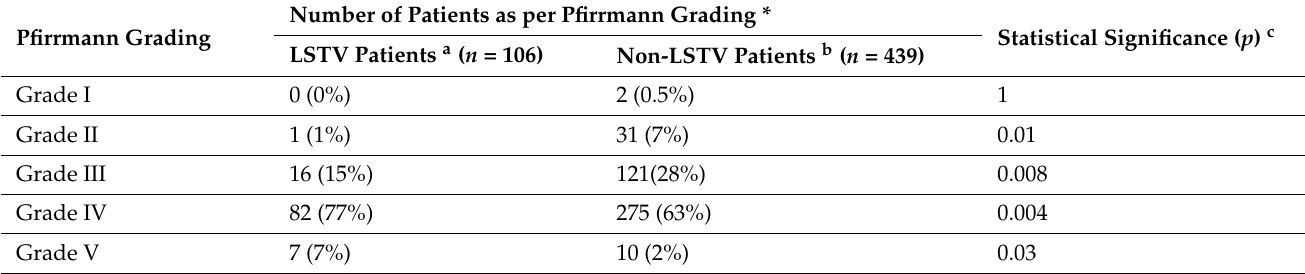
Table 2. Comparison of disc degeneration at the suprajacent level. Number of Patients as per Pfirrmann Grading Pfirrmann Grading